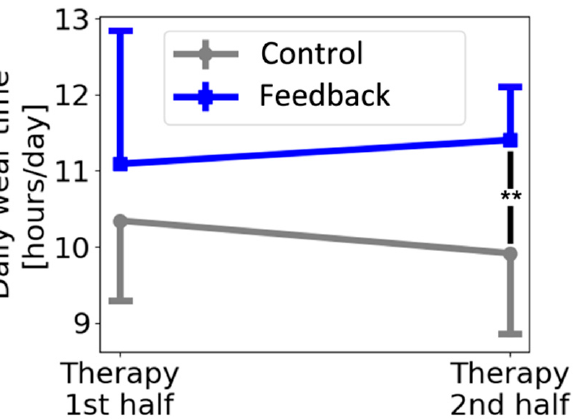
Figure 5. Average daily wear time of the Manumeter. There was a significant difference between groups ( t -test, p = 0.002) during the second half of the three weeks of therapy. Error bars show ±1 standard deviation.